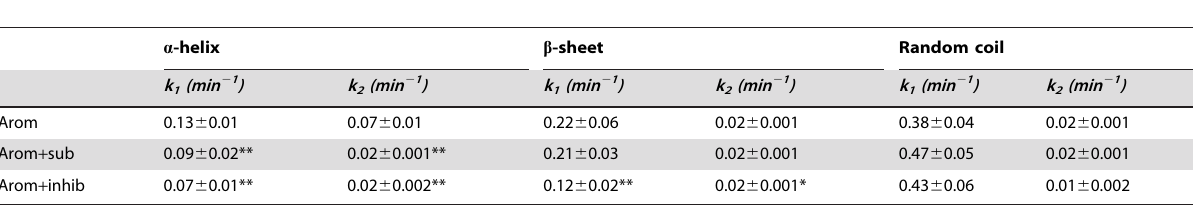
Table 2. H/D exchange rates of the secondary structure elements.